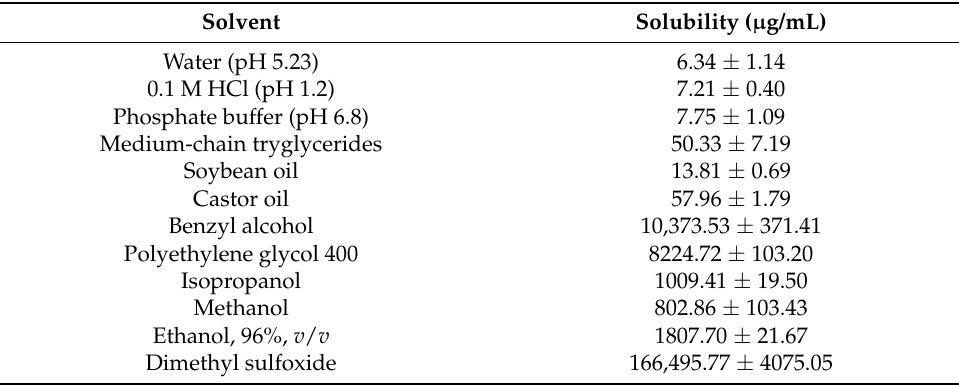
Table 2. Solubility of DK-I-60-3 in investigated solvents (mean ± SD, n = 3).